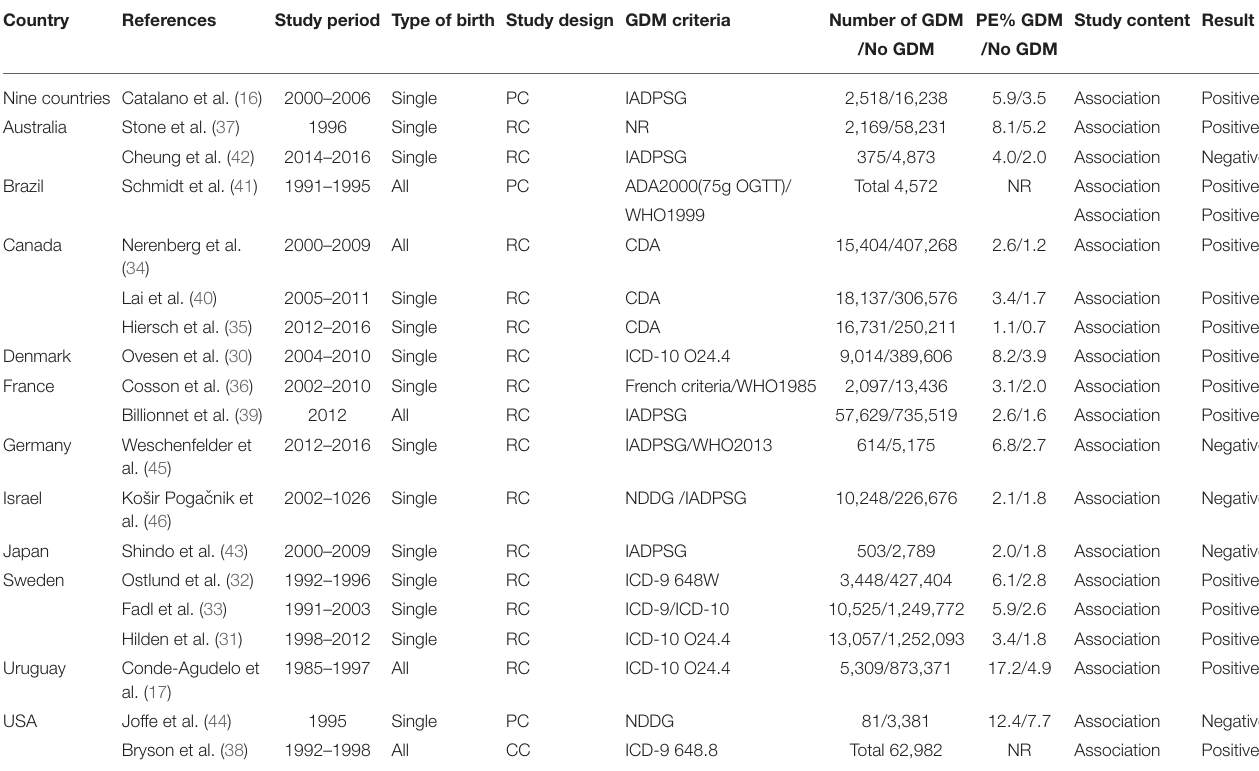
TABLE 1 | The independent association of gestational diabetes mellitus with preeclampsia.